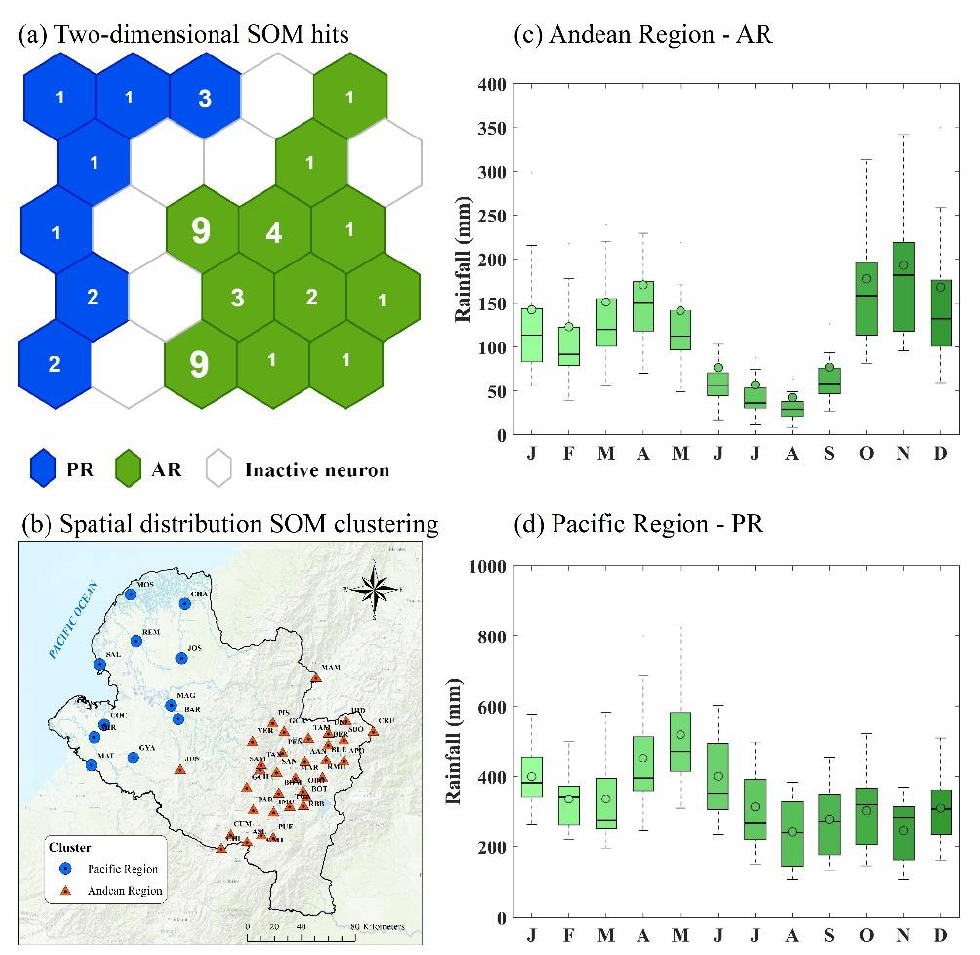
Figure 4. Regionalization of monthly rainfall in Southwestern Colombia.